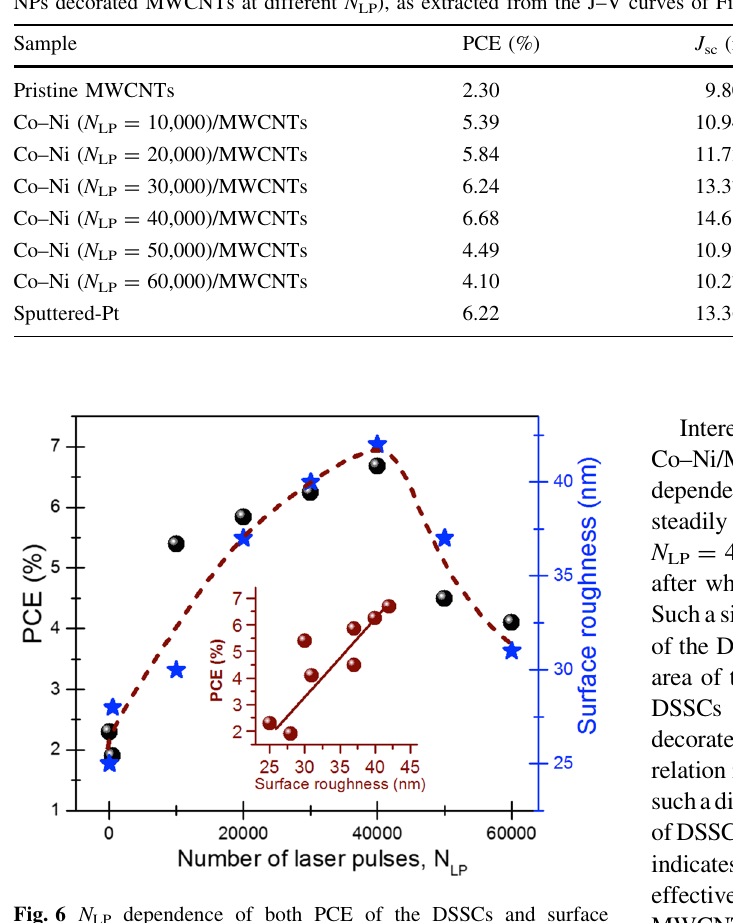
Fig. 6 N LP dependence of both PCE of the DSSCs and surface roughness of their Co–Ni/MWCNTs counter electrodes. The inset shows a fairly linear correlation between PCE of the different DSSCs and the surface roughness of their Co–Ni/MWCNTs counter